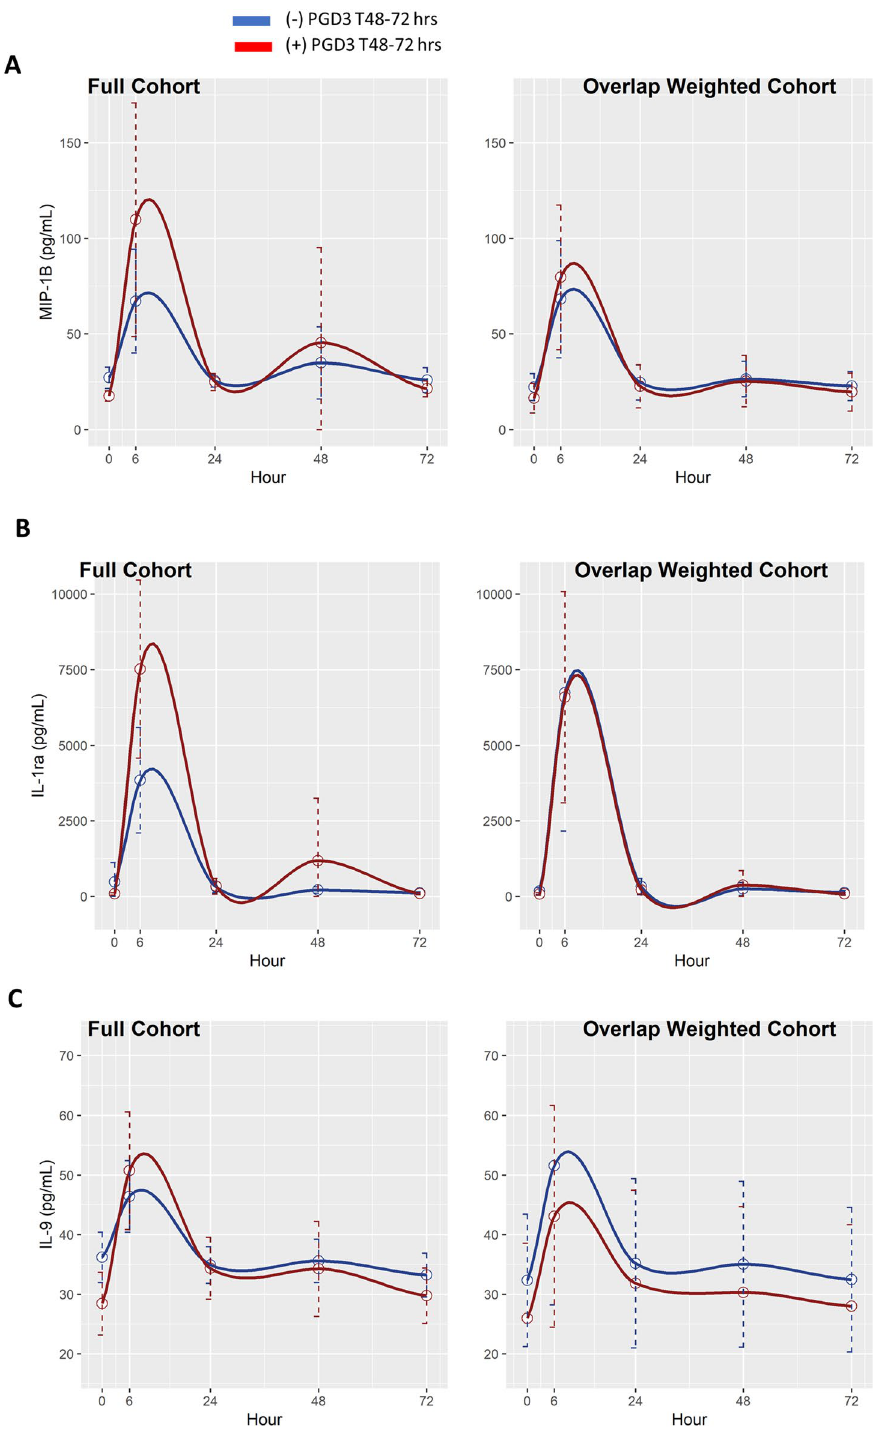
Figure 3. Temporal analysis. Differences in evolution for circulating biomarkers in patients with (red) or without (blue) PGD3 at T48–72 h in the full and overlap weighted cohort are shown. The overlap weighted cohort was adjusted for the following factors: BMI, hypertension, type of transplant, EVLP, and type of ECLS. ( A ) Macrophage inflammatory protein (MIP)-1B, ( B ) interleukin (IL)-9, and ( C ) interleukin-1 receptor antagonist (IL-1Ra). Circles represent the average biomarker level at respective time points; dotted lines represent 95% confidence intervals for the biomarker level at respective time points. The image was created using R software version number 4.1.3 (https:// cran.r- proje ct.